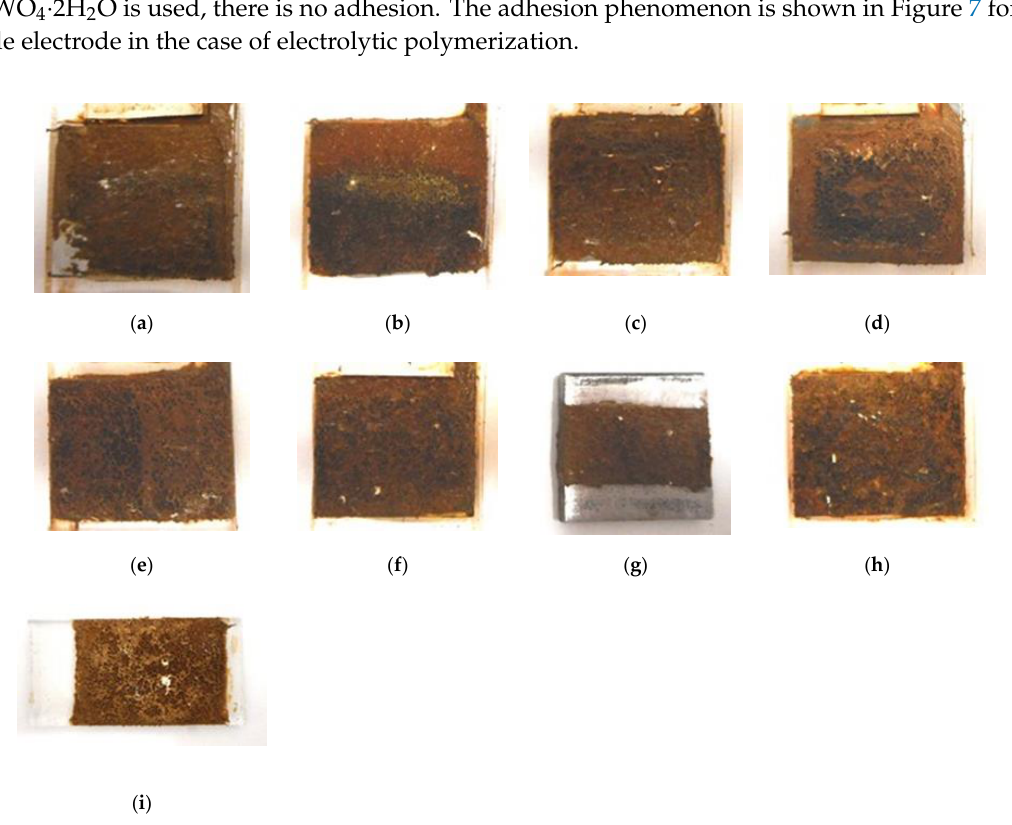
Figure 7. Images of surface of metal on cathode-side electrode after electrolytic polymerization with PVA, Na 2 WO 4 ·2H 2 O, KF96 (1000 cSt) under an applied magnetic field; ( a ) aluminum; ( b ) stainless steel; ( c ) nickel; ( d ) zinc; ( e ) lead; ( f ) brass; ( g ) iron; ( h ) copper; ( i ) glass coated by TiO 2 .